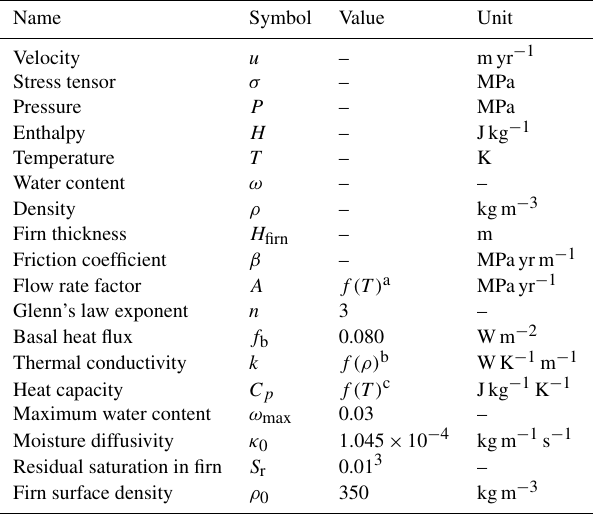
Table 2. Variables and parameters of the thermo-mechanical